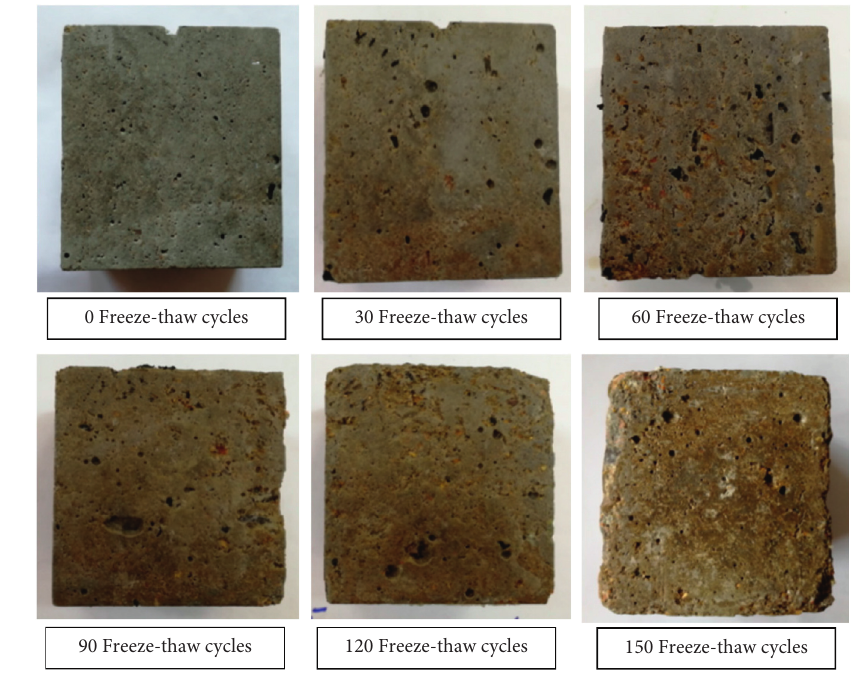
Figure 5: Appearance of CRC after different freeze-thaw cycles.